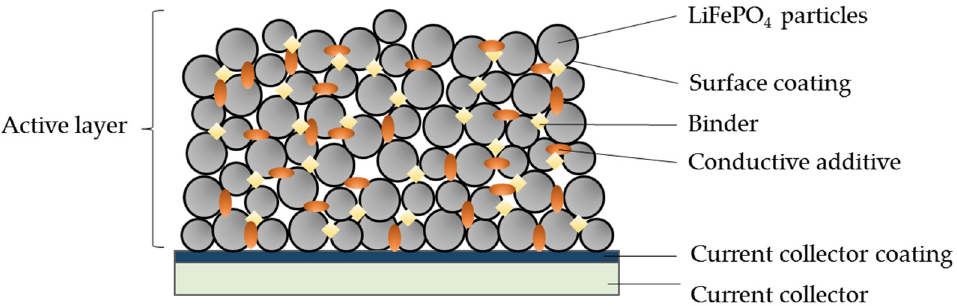
Figure 1. A conventional LFP electrode design.